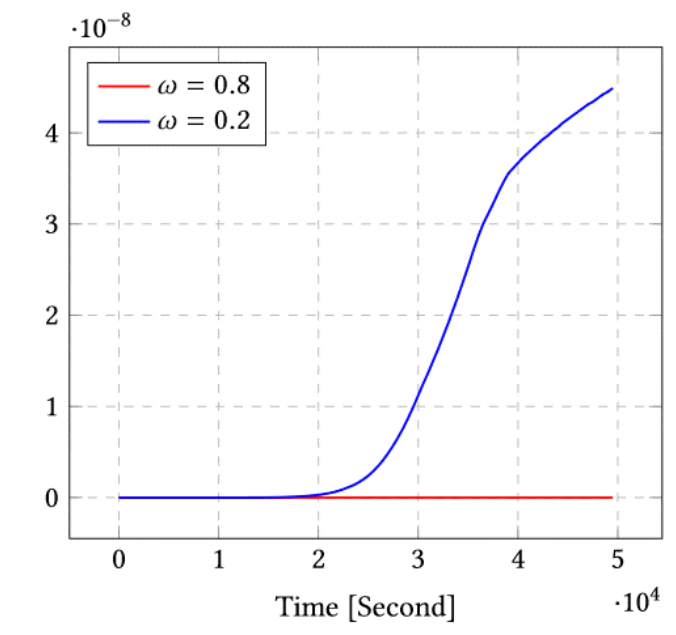
Figure 7. Diversity for ω = 0.8 and ω = 0.2 for the case of 20 sensors.